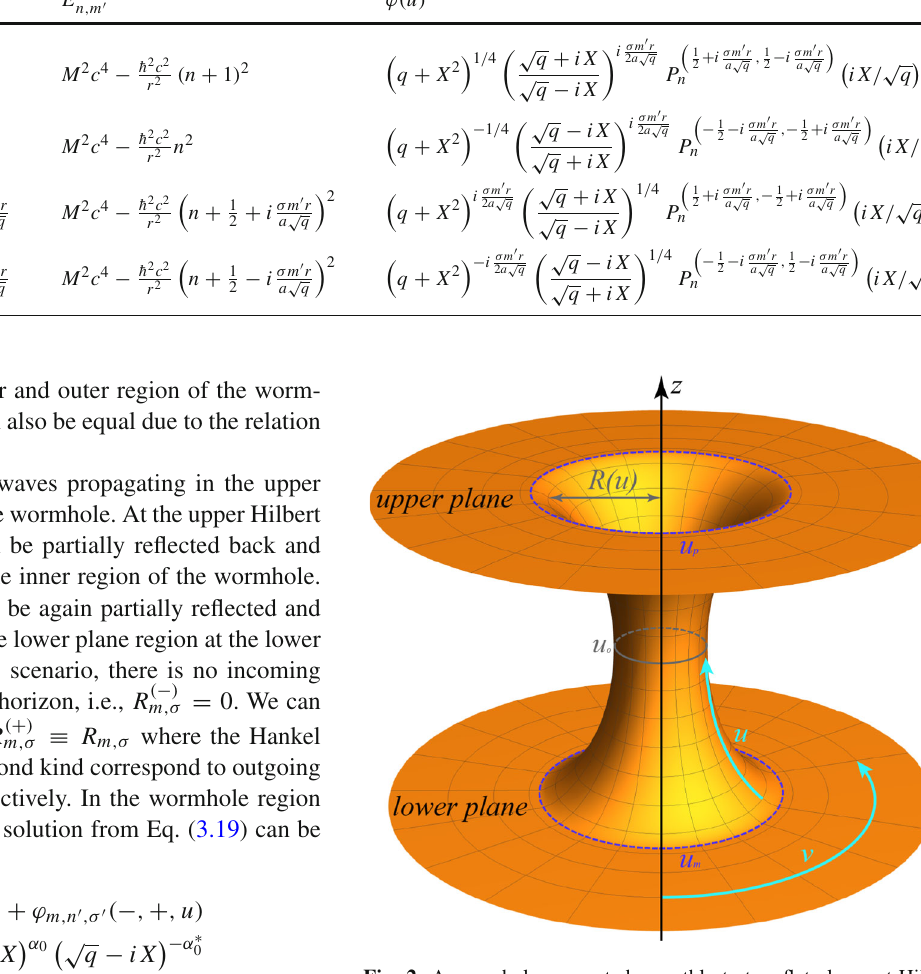
Fig. 2 A wormhole connected smoothly to two flat planes at Hilbert horizons